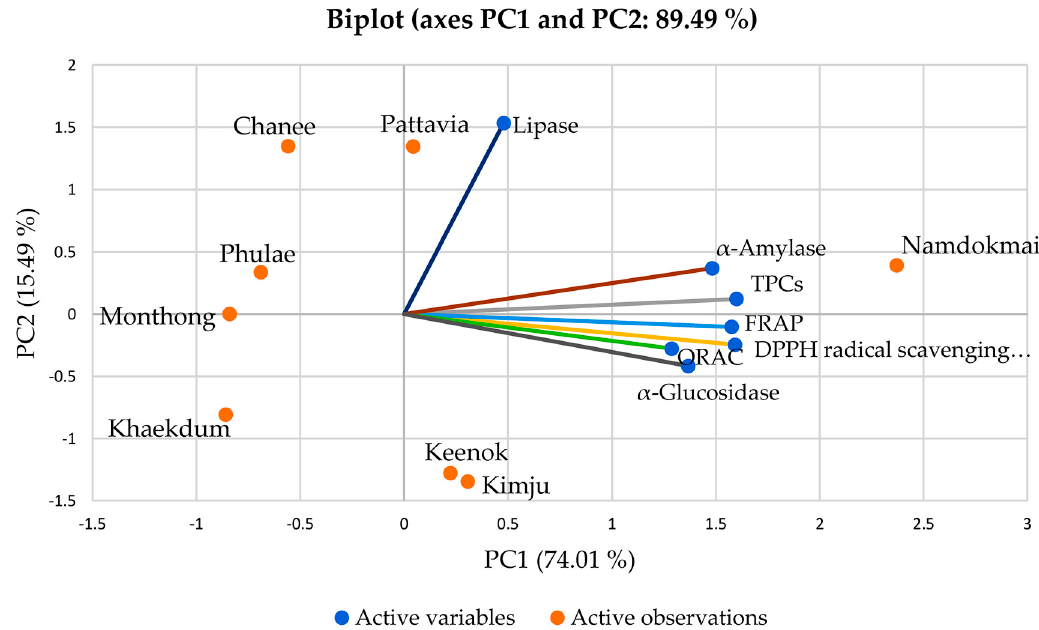
Figure 5. The biplot from principal component analysis (PCA) from mean values of all variables of the eight fruit extracts.